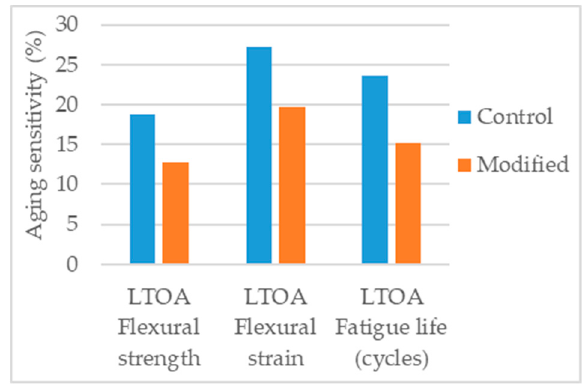
Figure 16. Aging sensitivity of the parameters considered in the study [24].